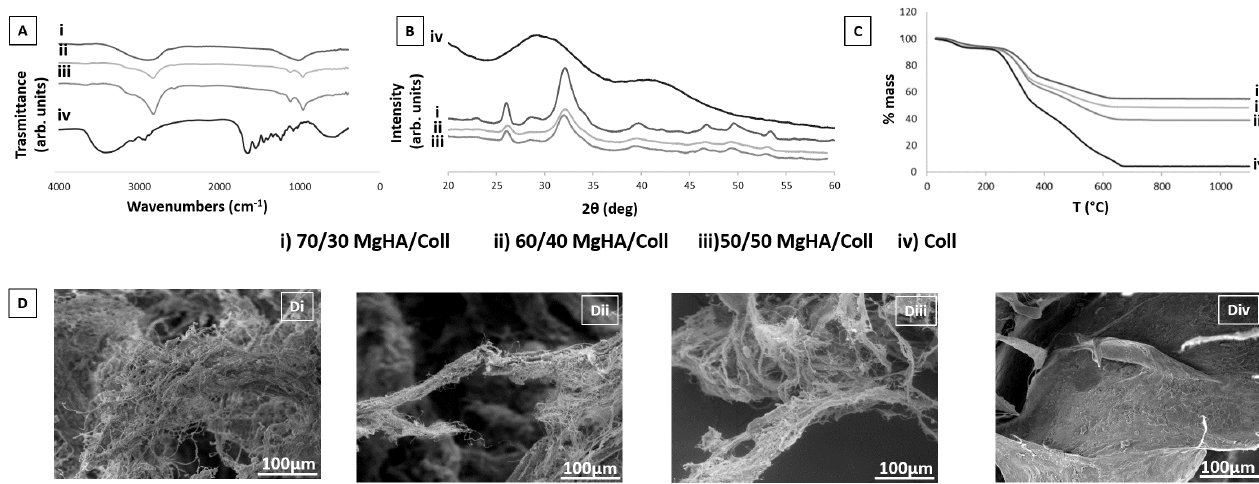
Figure 2. Chemical-physical characterizations of the four different scaffold formulations (MgHA/Coll 70/30, 60/40, 50/50, and Coll). ( A ) FTIR analyses, ( B ) XRD diffractograms, ( C ) TGA analyses, and ( D ) ESEM analyses: ( Di ) MgHA/Coll 70/30, ( Dii ) MgHA/Coll 60/40, ( Diii ) MgHA/Coll 50/50, and ( Div ) Coll, show scaffold porosity and a fibrous morphology typical of the collagen component, while ( Di–Diii ) highlights the uniform distribution of mineral MgHA